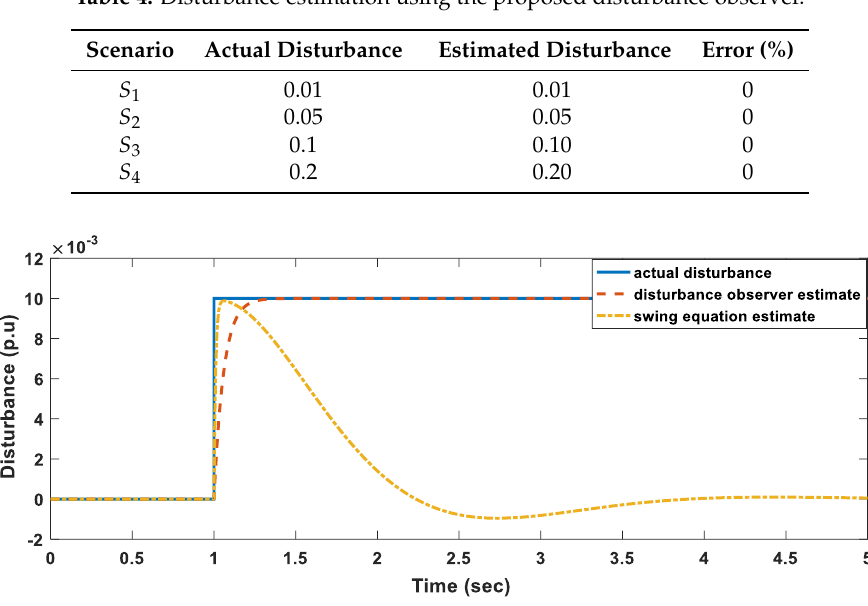
Table 4. Disturbance estimation using the proposed disturbance observer.